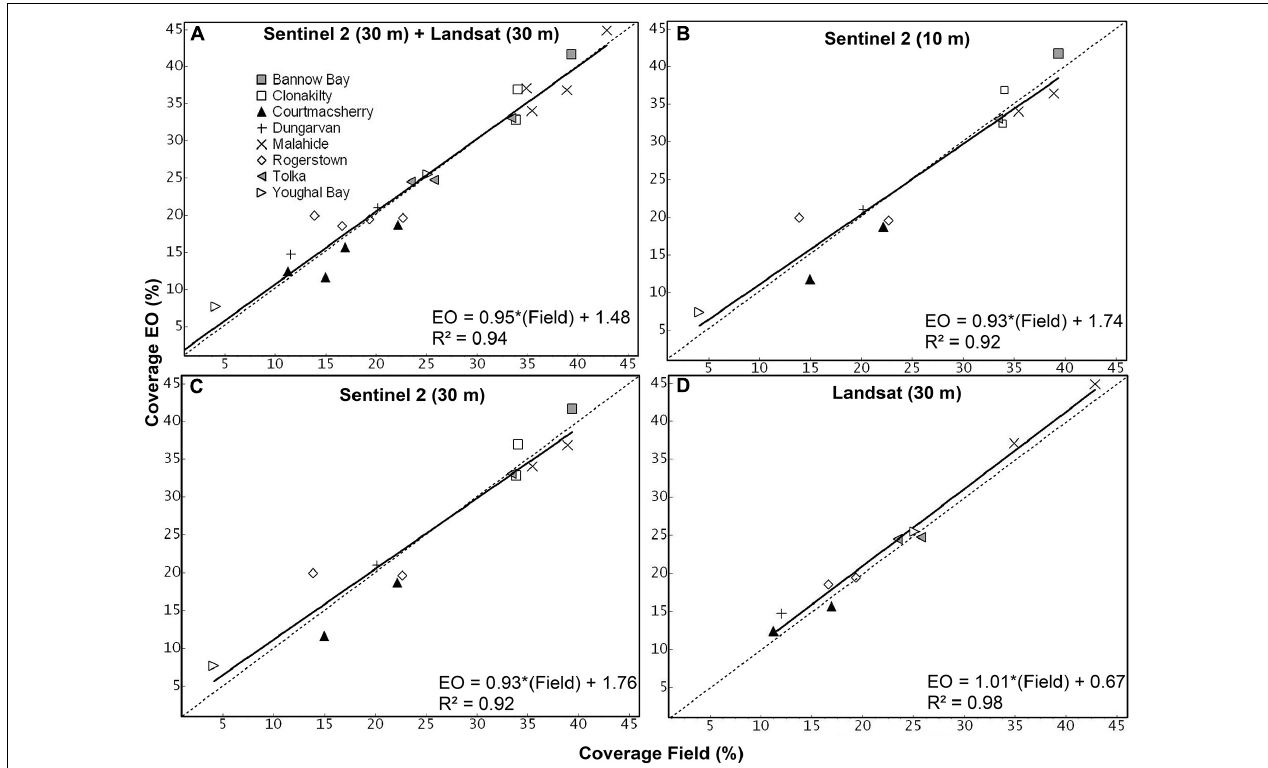
FIGURE 5 | Scatterplots showing the comparison between coverage computed using the EO and coverage obtained using the field survey for four groups based on the resolutions of the EO data sets: (A) resampled Sentinel-2 30 m and Landsat 30 m, (B) Sentinel-2 10 m, (C) resampled Sentinel-2 30 m, and (D) Landsat 30 m. The equation of the trend line, the associated R 2 values have been shown for each plot. The 45 ◦ line with 1:1 correspondence between EO and field data has been shown as a dotted line for